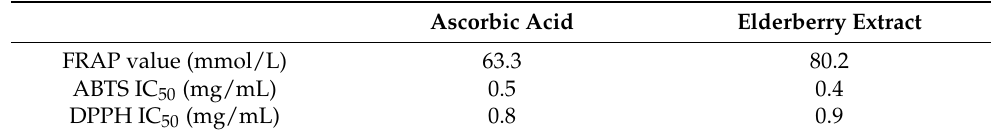
Table 6. Evaluation of antioxidant activity of elderberry